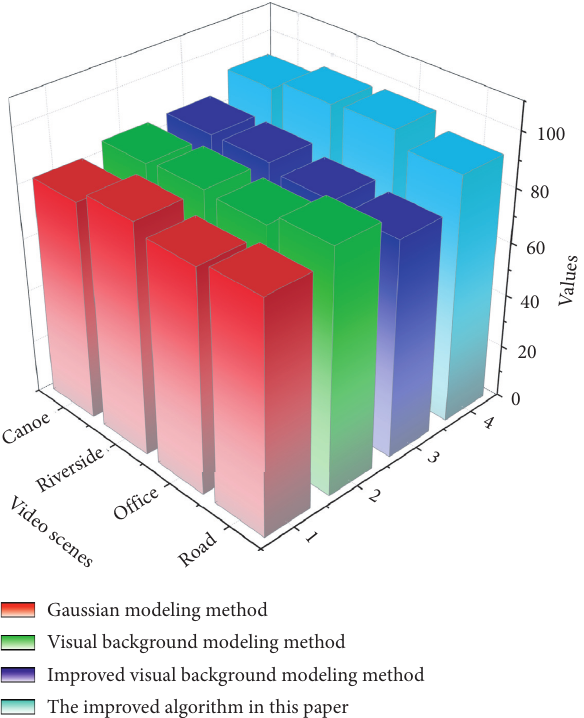
Figure 5: Comparison of accuracy of different